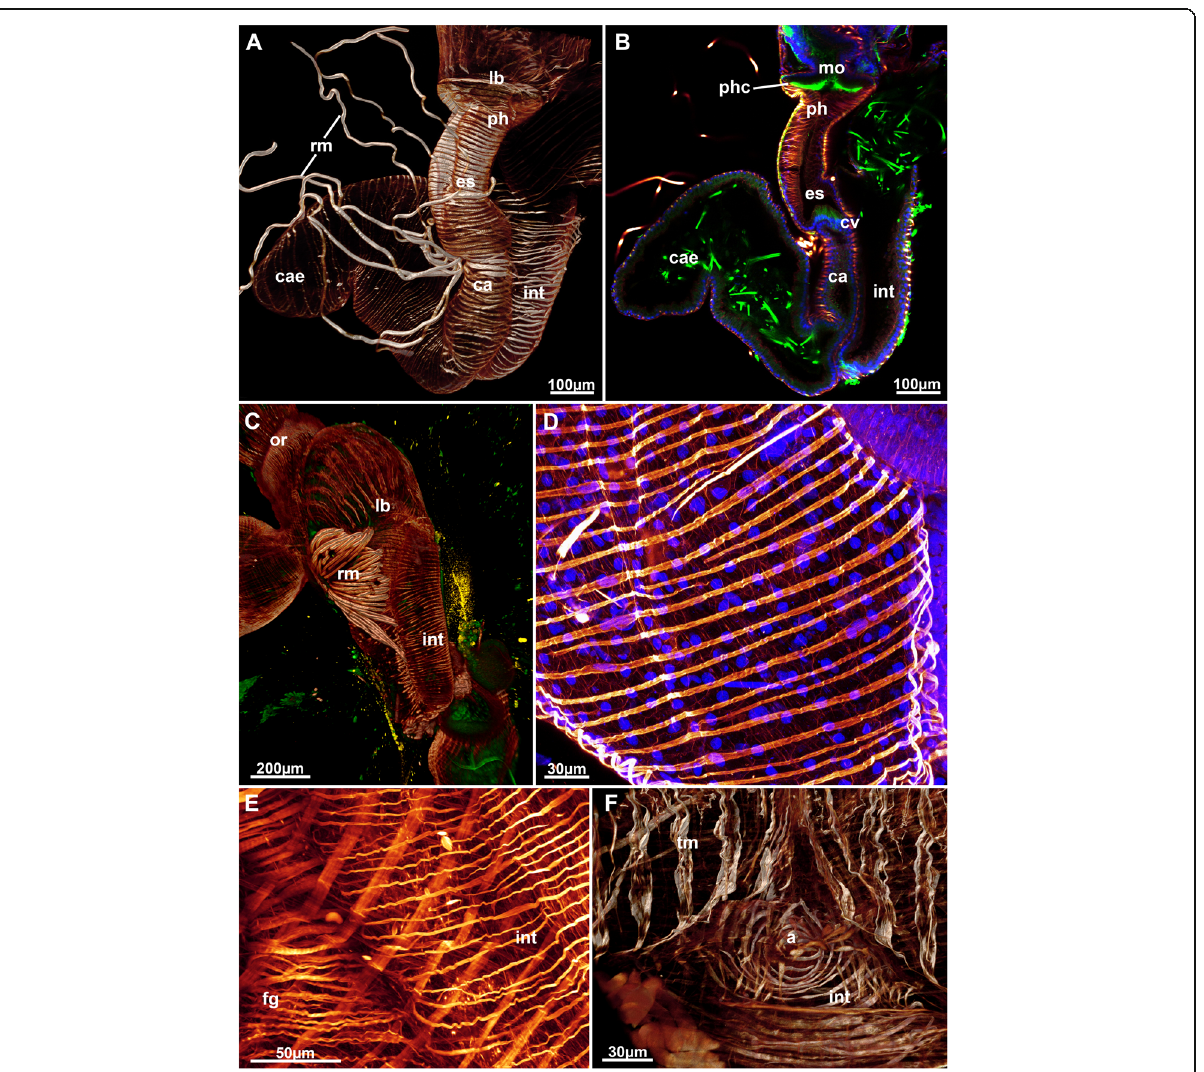
Fig. 11 Muscular system of the digestive tract of Stephanella hina . Confocal laser scanning microscopy stacks based on f-actin labelling. Volume renderings, projections or optical slices. F-actin in glow LUT. a Volume rendering of a dissected zooid showing the major areas of the gut. b Optical section of the data set in A showing the border between the esophagus and the cardia. c Volume rendering showing the fanned retractor muscle inserting into various sites of the oral digestive tract. d Detail of the smooth circular muscles of the caecum. e Detail of the circular muscles of the foregut showing cross-striation and the smooth hindgut, the intestine. f View of the circular muscles of the